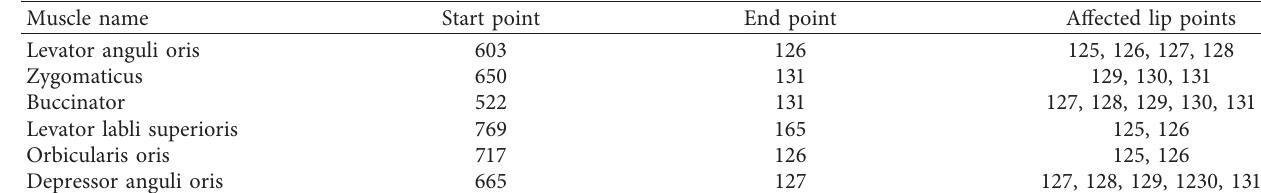
Table 2: The starting and ending coordinates of each